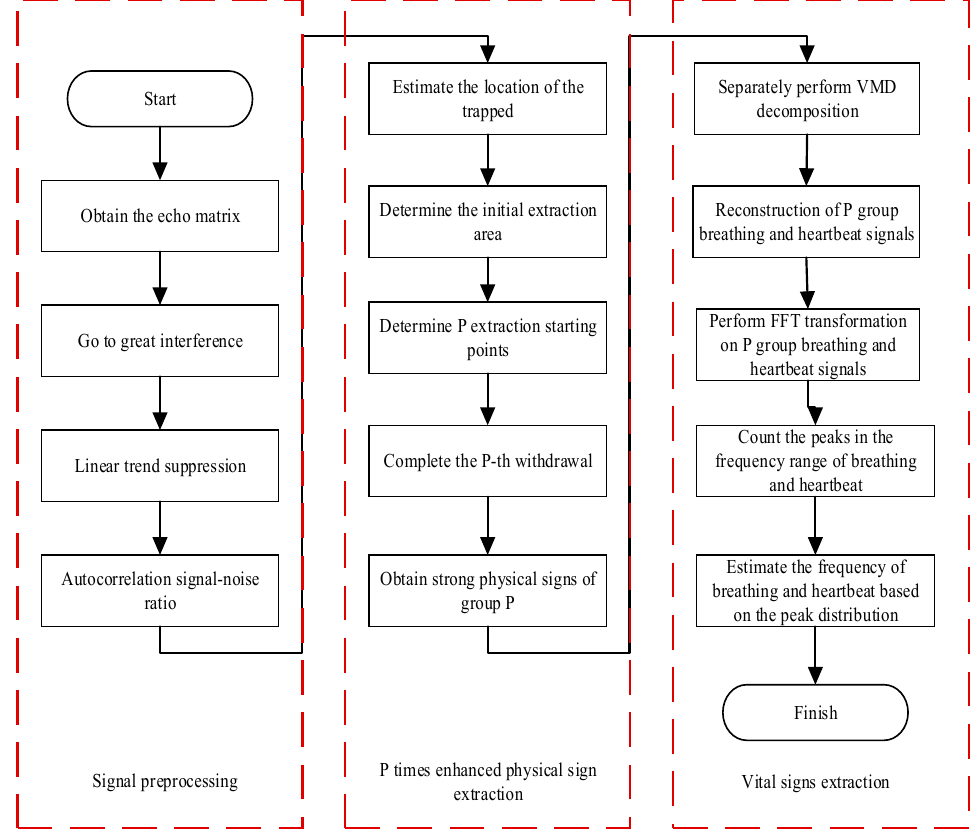
Figure 11. Flowchart of vital signal extraction algorithm.